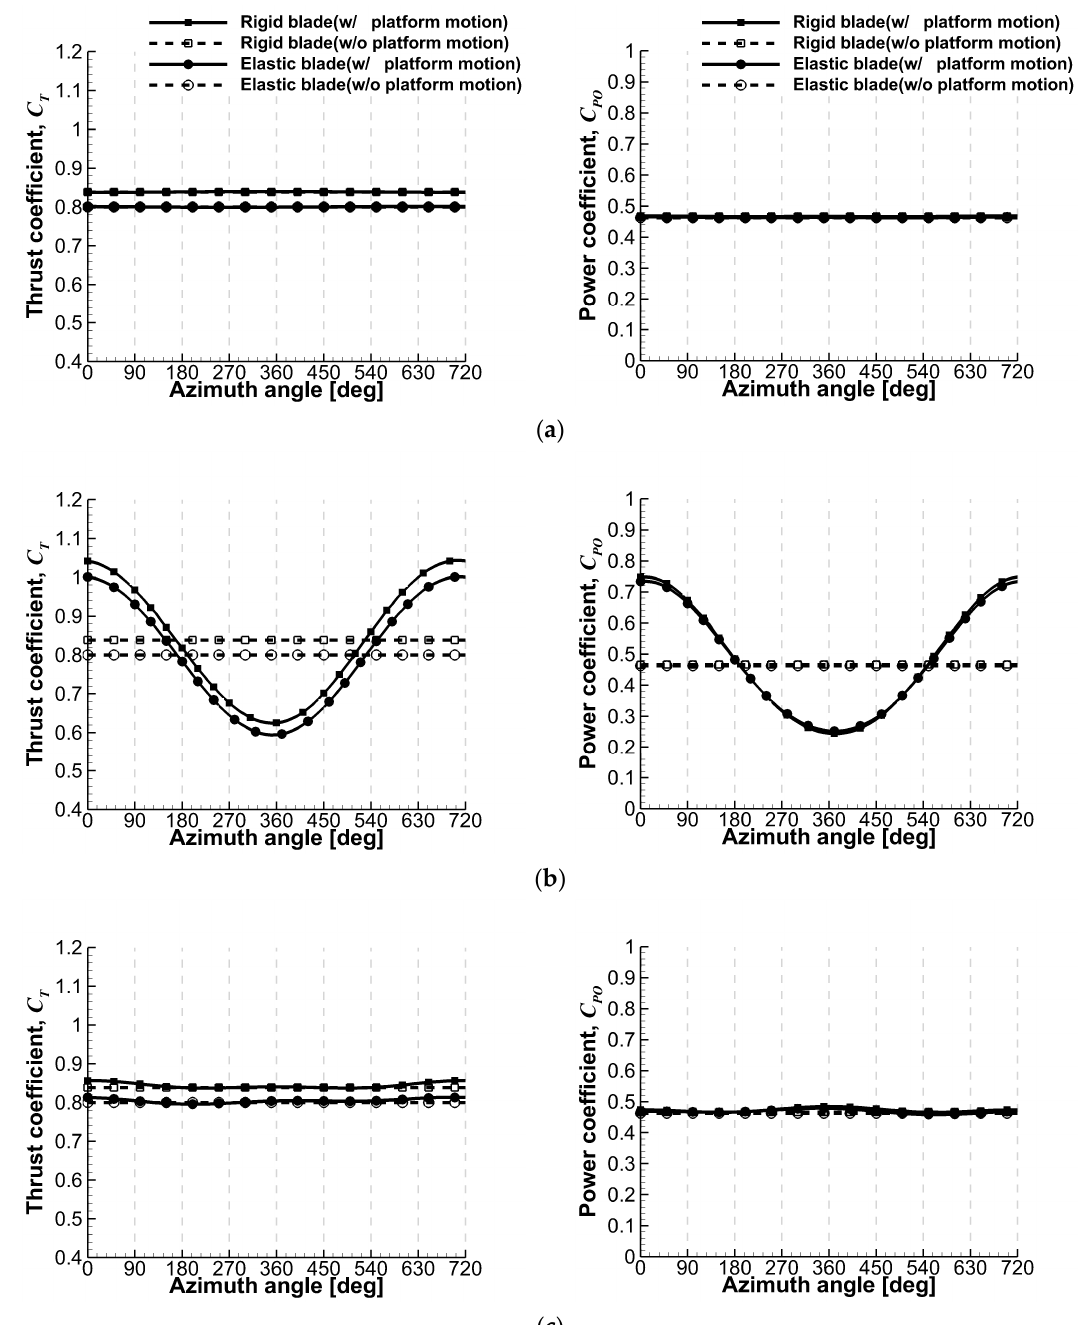
Figure 13. Rotor aerodynamic loads under rotational platform motions. ( a ) Yaw motion. ( b ) Pitch motion. ( c ) Roll motion.